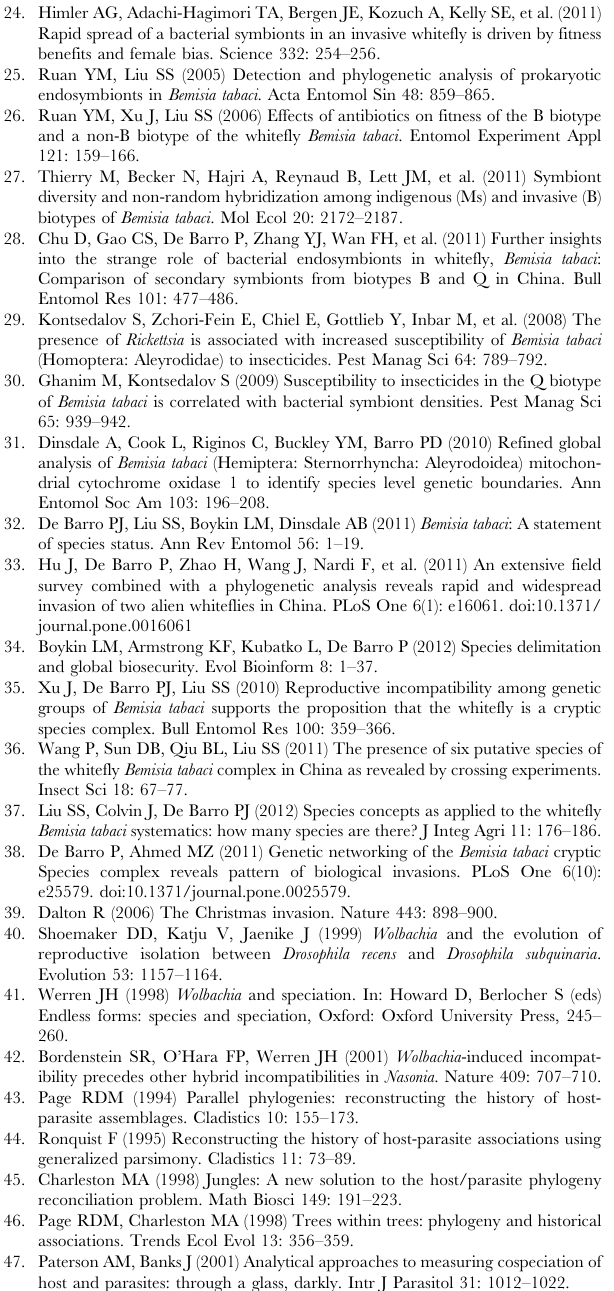
Table S1 Asian B. tabaci cryptic species population sampled for